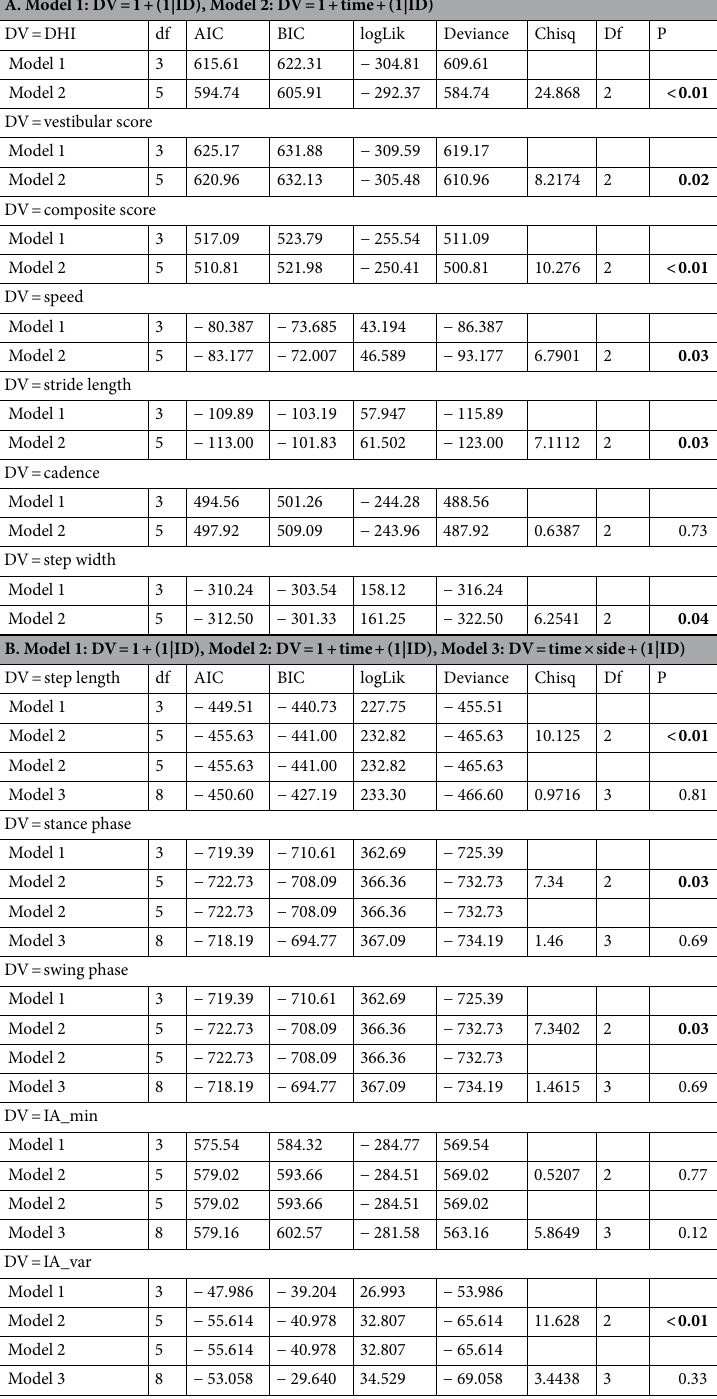
Table 2. Results from likelihood-ration test via ANOVA to test the significance of time and side effects. The random effect structure of participants was retained (random intercept, 1| ID). DV is the dependent variable and ID is the number of participants. DHI Dizziness Handicap Inventory, IA inclination angle in the frontal plane, Var